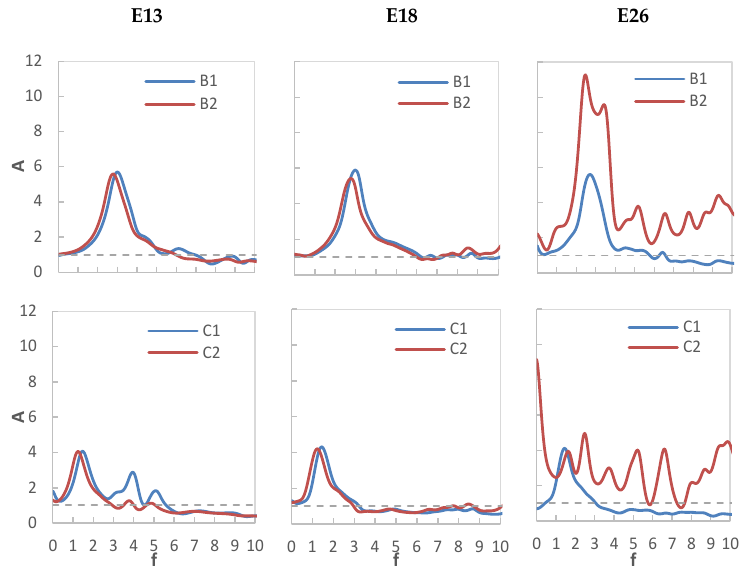
Figure 15. Comparison between the amplification functions obtained for the FF alignment (visco-nonlinear analyses).